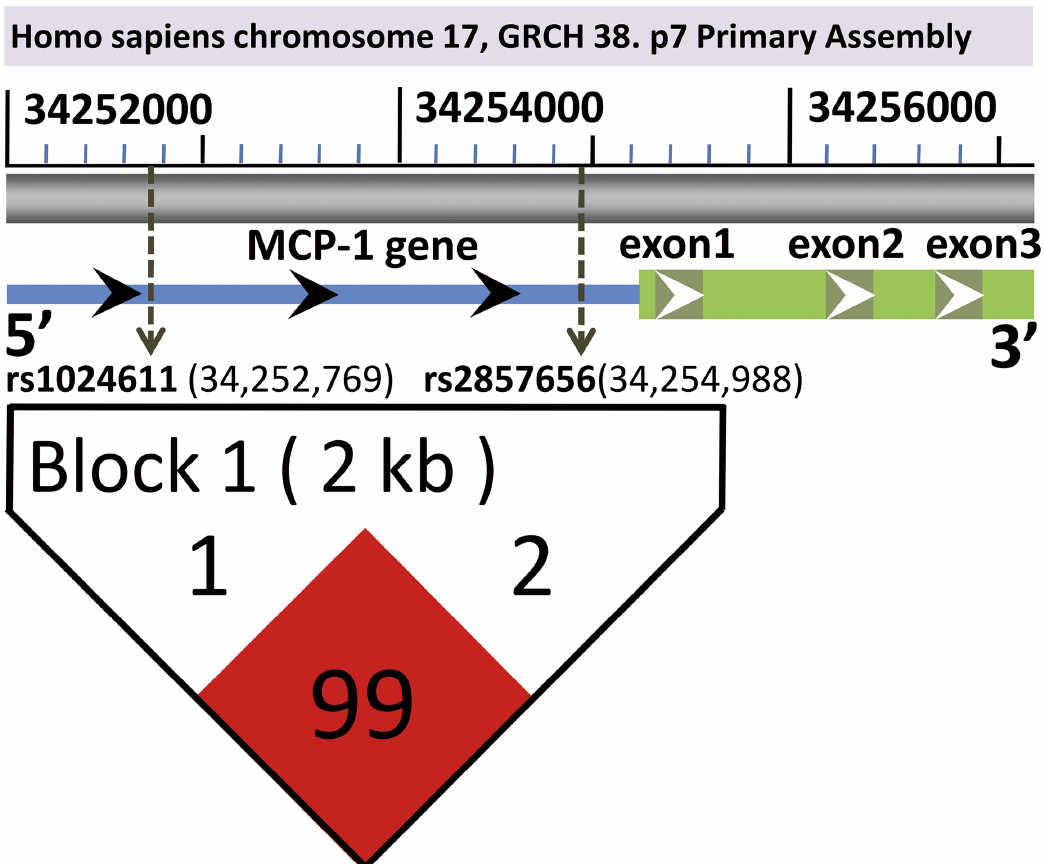
Fig 1. The linkage disequilibrium (LD) block (rs1024611and rs2857565) and their locations in the promoter region of the MCP-1 gene. According to the GRCh38.p7 primary assembly, the humanMCP-1 gene is locatedin Homo sapienschromosome 17 (34,255,277–34,257,203).The blue bar represents the 5’-flanking region of the MCP-1 gene, and the three dark green bars individually represent its exon1, exon2and exon3, respectively. In the visual, rs1024611 and rs2857656are located in the upstream of the transcriptional start site (-2508 bp and -289 bp), respectively. The haplotypeblock (rs1024611-rs2857656,D’ value = 0.995, r 2 = 0.988) is generatedusing Haploview4.2.